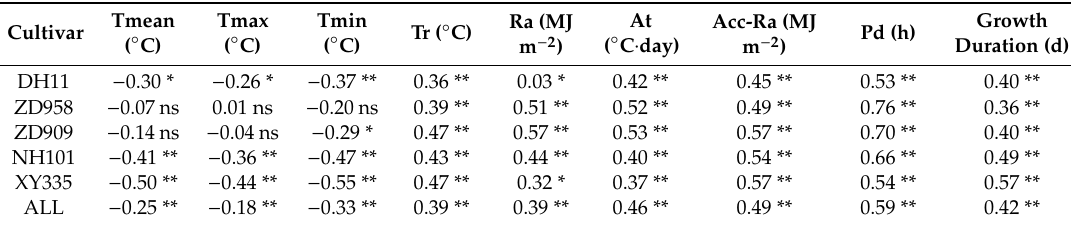
Table 4. Relationships between final leaf number and climatic factors and growth days during the maize vegetative growth stage.